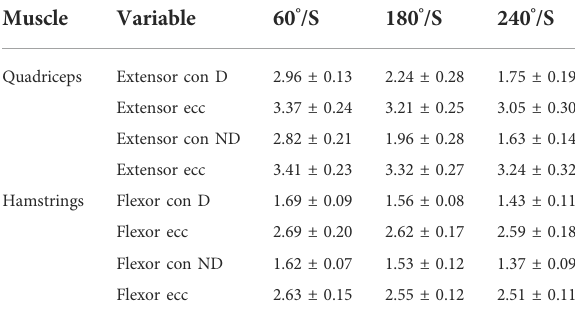
TABLE 3 Quadriceps and hamstring strength on both sides of the limb for the non-elite group.